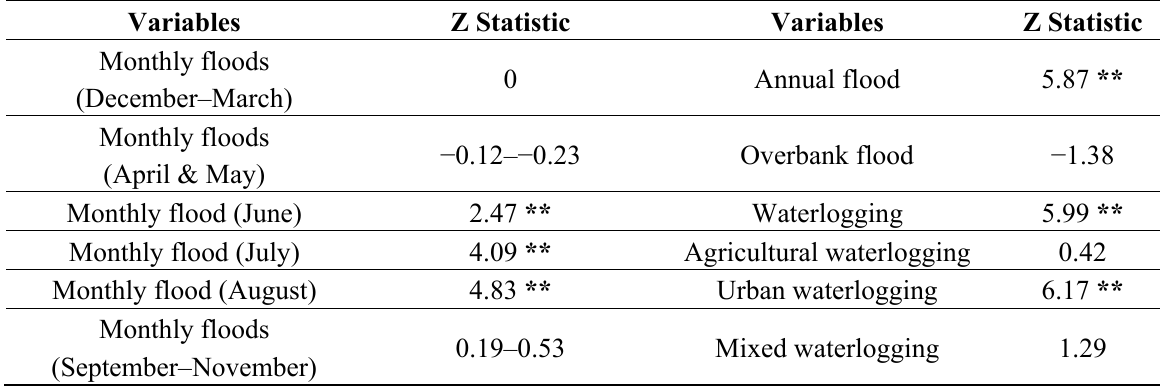
Table 2. MK Z statistics for monthly floods, annual flood, and subtype floods.